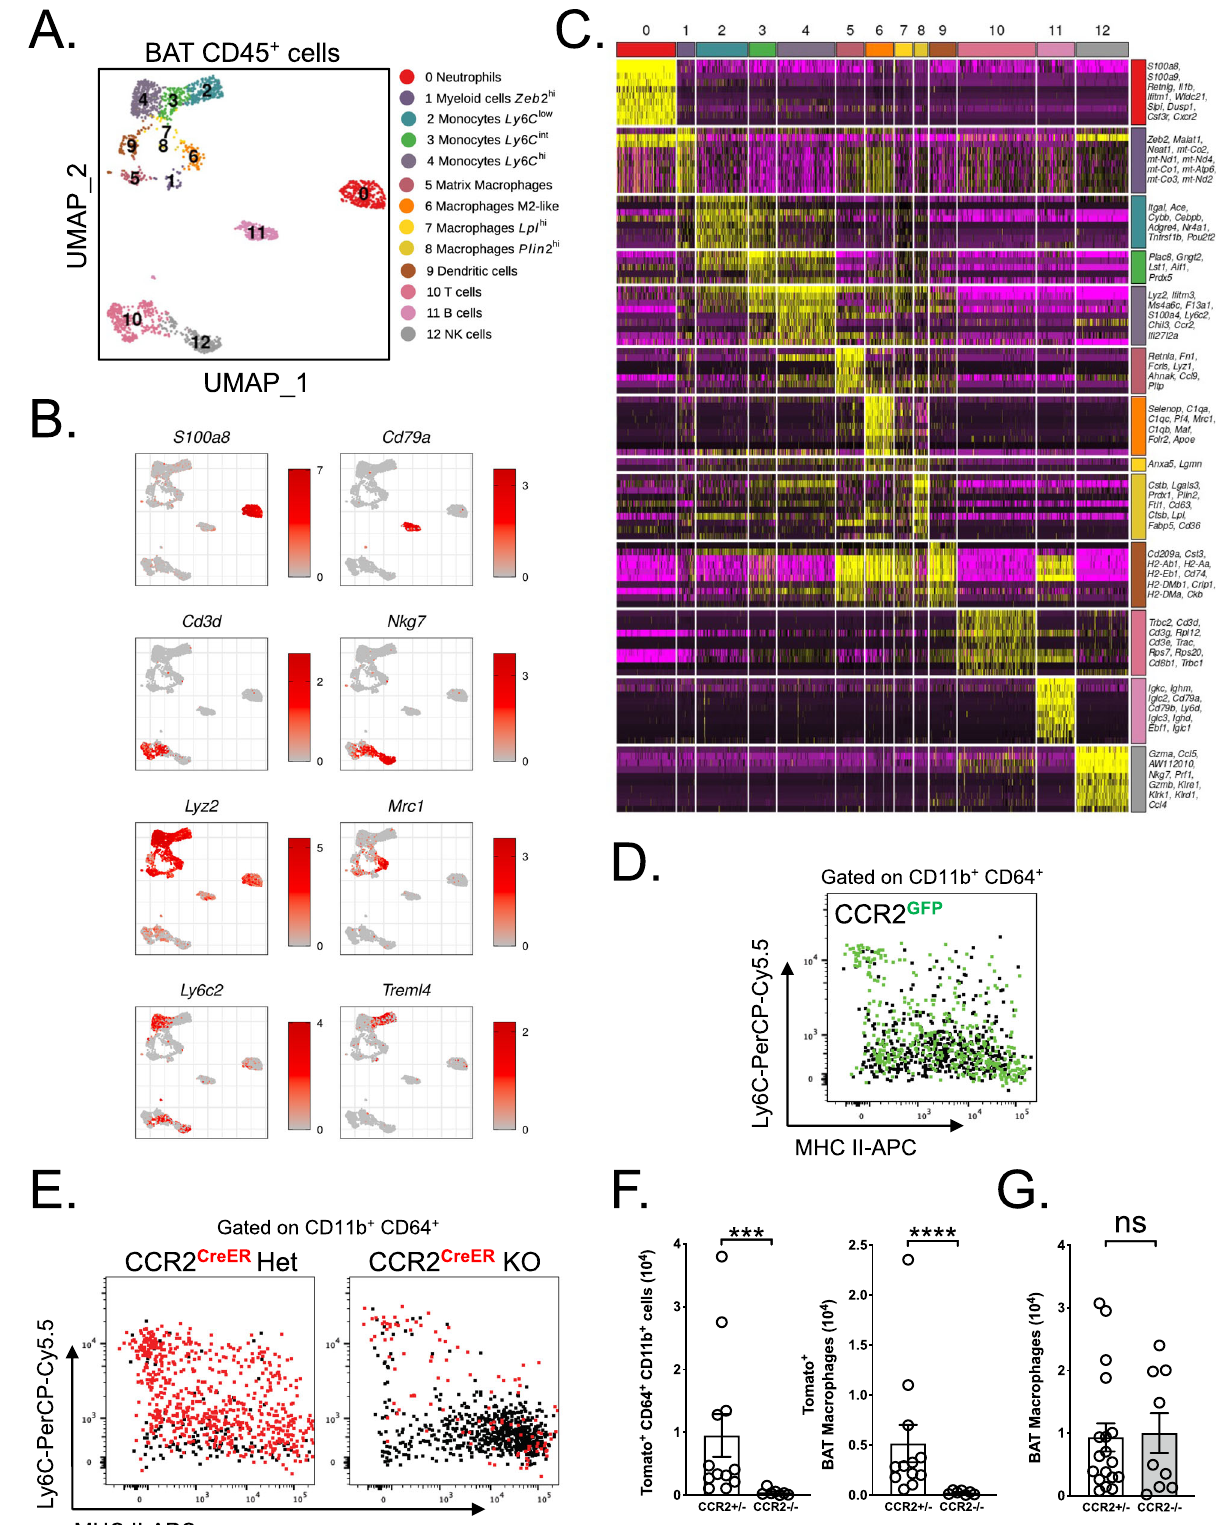
macrophages or neutrophils, previously shown to express this protein 17 but in which the adiponectin promoter is not active. As expected, serum glycerol concentrations were decreased in Adi- po Δ / Δ mice compared to control animals (Fig. S1E). Serum lipi- domic analysis further revealed decreased concentrations of palmitic acid (C16:0), the most abundant non-esteri fi ed fatty